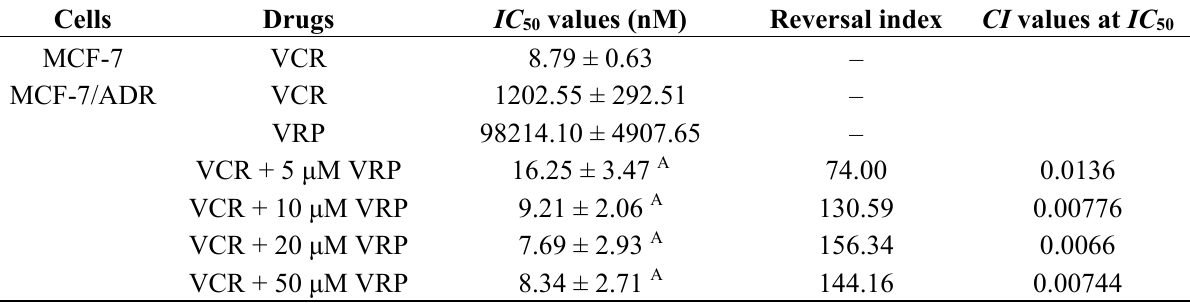
Table 1. Cytotoxicities of VCR, VRP, VCR/VRP against drug-sensitive cells and drug-resistant cells ( n =